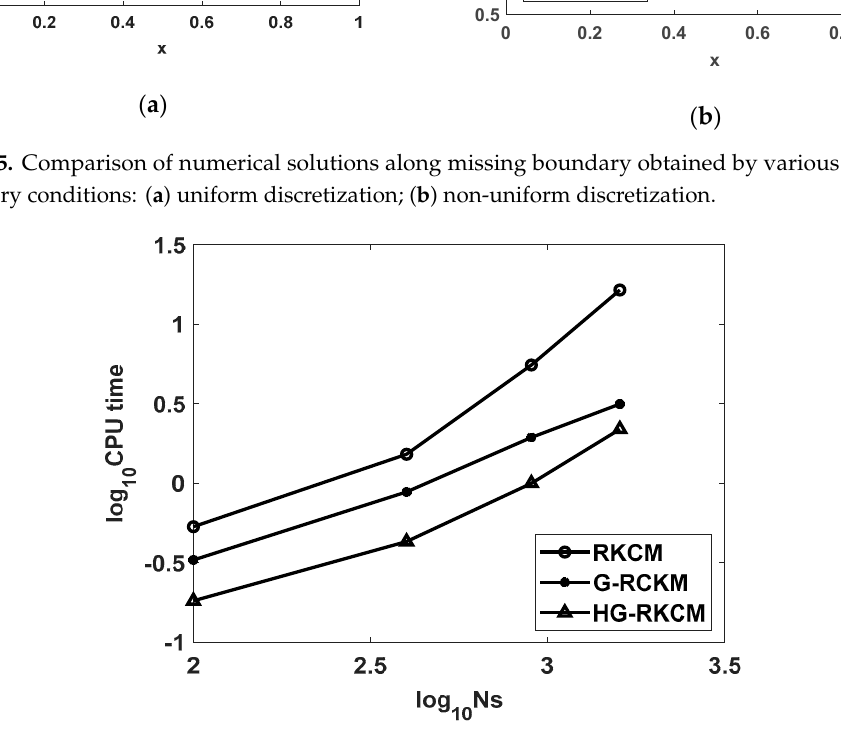
Figure 6. Comparison of CPU t ime by different methods in the square domain.